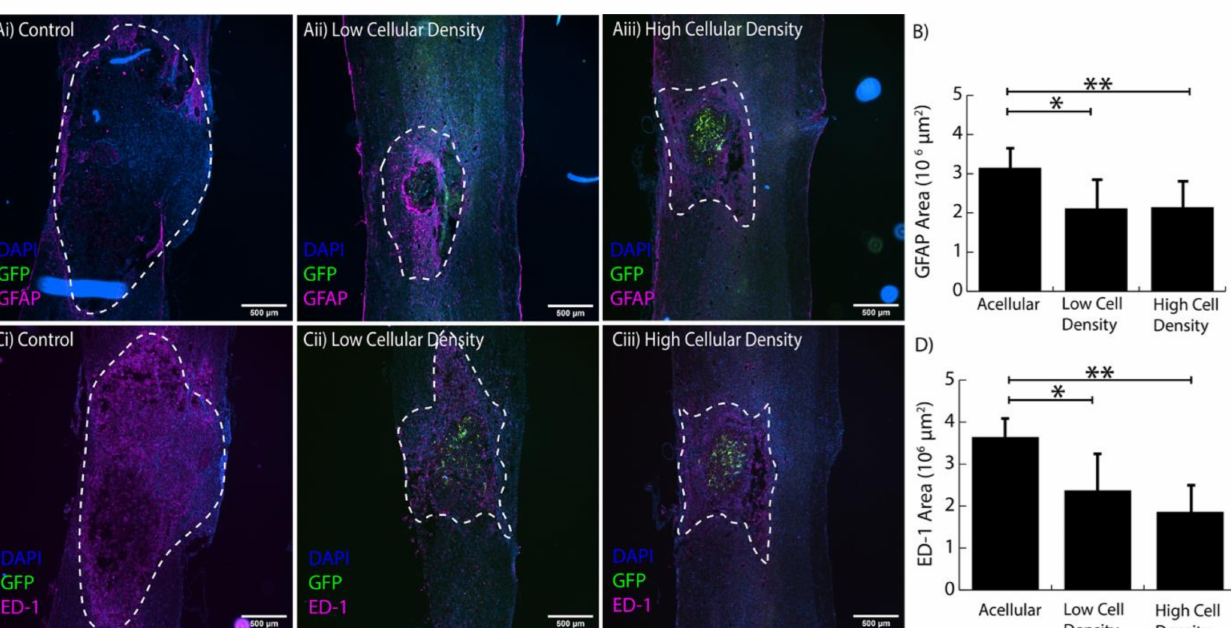
Figure 5. Quantification of injury area and inflammation following injection of peptide hydrogels. Reactive gliosis in response to peptide hydrogels in ( Ai ) acellular peptide, ( Aii ) low cell density, and ( Aiii ) high cell density. DAPI (blue), GFP (green), GFAP (magenta). ( B ) Injury area quantification. Data presented as mean ± s.d. * p < 0.05, ** p < 0.001 ( C ) Inflammatory response following scaffold transplantation, ( Ci ) acellular peptide, ( Cii ) low cell density, and ( Ciii ) high cell density. ( D ) Inflammation area quantification. Data presented as mean ± s.d. * p < 0.05, ** p < 0.001. Scale = 100- µ m. (For interpretation of the references to color in this figure legend, the reader is referred to the web version of this article. Reproduced with permission from [86], Elsevier,